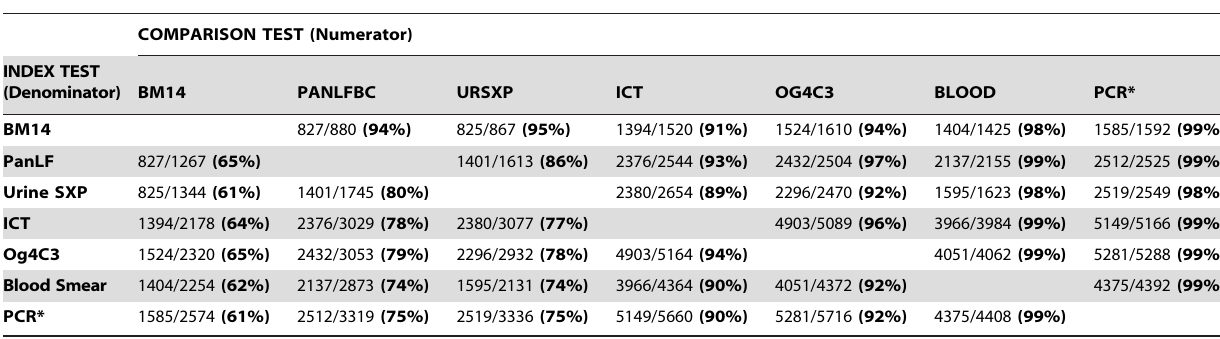
Table 12. Negative-to-negative test concordance in community survey.